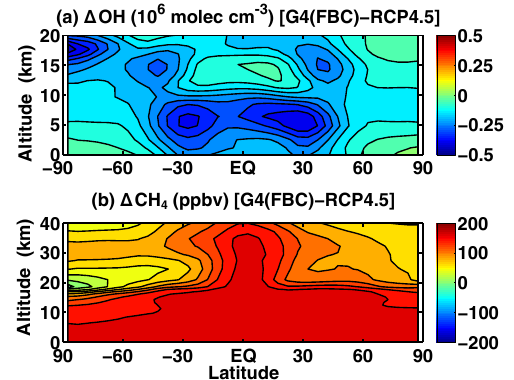
Figure 12. ULAQ-CCM calculated G4-RCP4.5 anomalies of (a) OH concentrations and (b) CH 4 mixing ratios (time av- erage 2040–2049) from experiment (b) in Table 1. Units are 10 6 moleccm − 3 for OH and ppbv for CH 4 . The contour line in- crement is 0.1 × 10 6 moleccm − 3 for OH and 25ppbv for CH 4 .